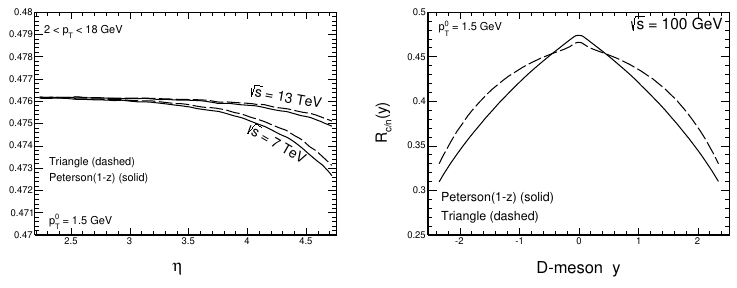
√ s = 7 and 13 TeV for the LHCb √ s = 100 GeV in the full phase-space